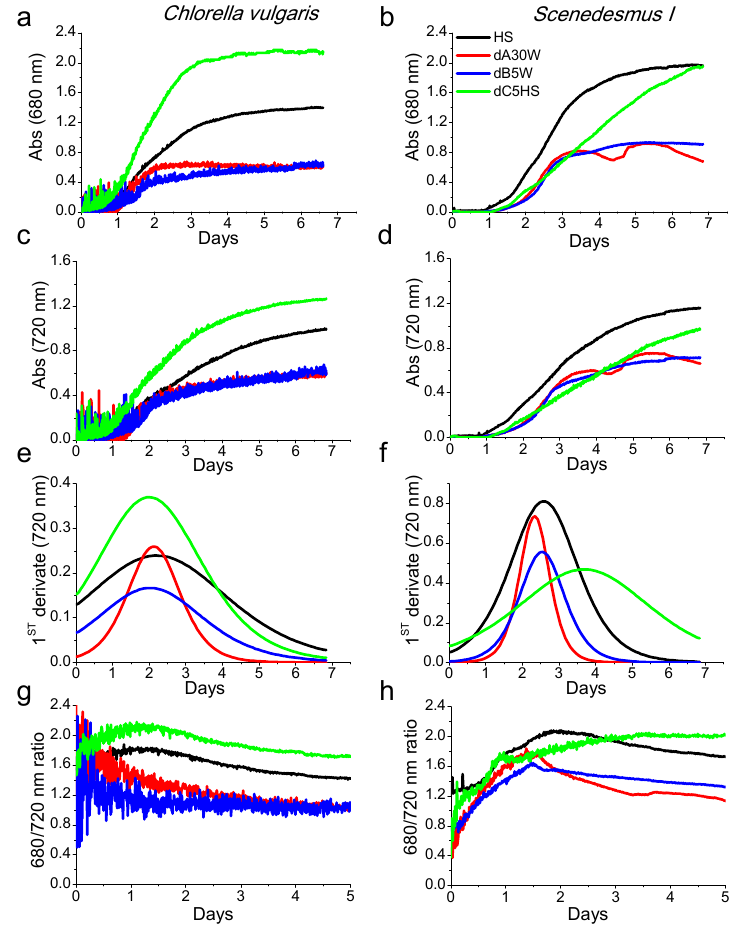
Figure 1. Growth kinetics measured at 680 and 720 nm of C. vulgaris and Scenedesmus I. ( a , c ) growth curves of C. vulgaris measured at 680 and 720 nm, respectively; ( b , d ) growth curves of Scenedesmus I measured at 680 and 730 nm, respectively; ( e , f ) first derivative of 720 nm growth kinetics; and ( g , h ) ratio of 680 and 720 nm absorption during cultivation.